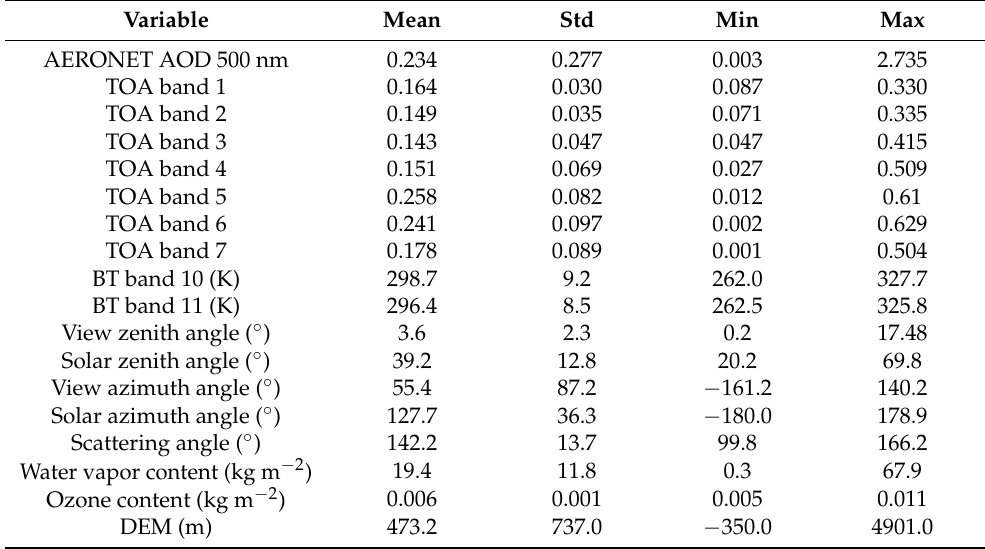
Table 2. Descriptive statistics for AERONET AOD and 17 predictor variables. The AOD and TOA reflectance are